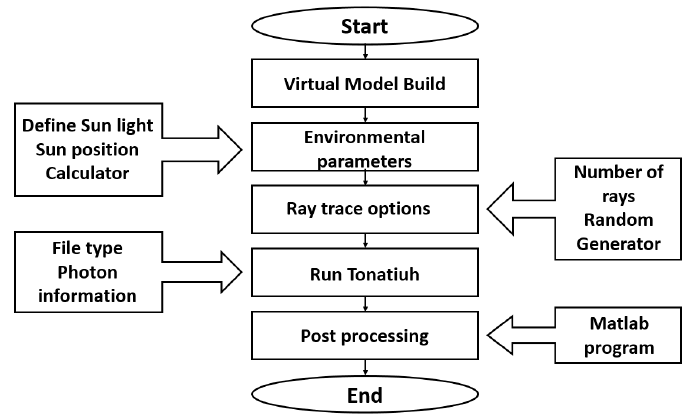
Figure 3. CPC flowchart methodology.